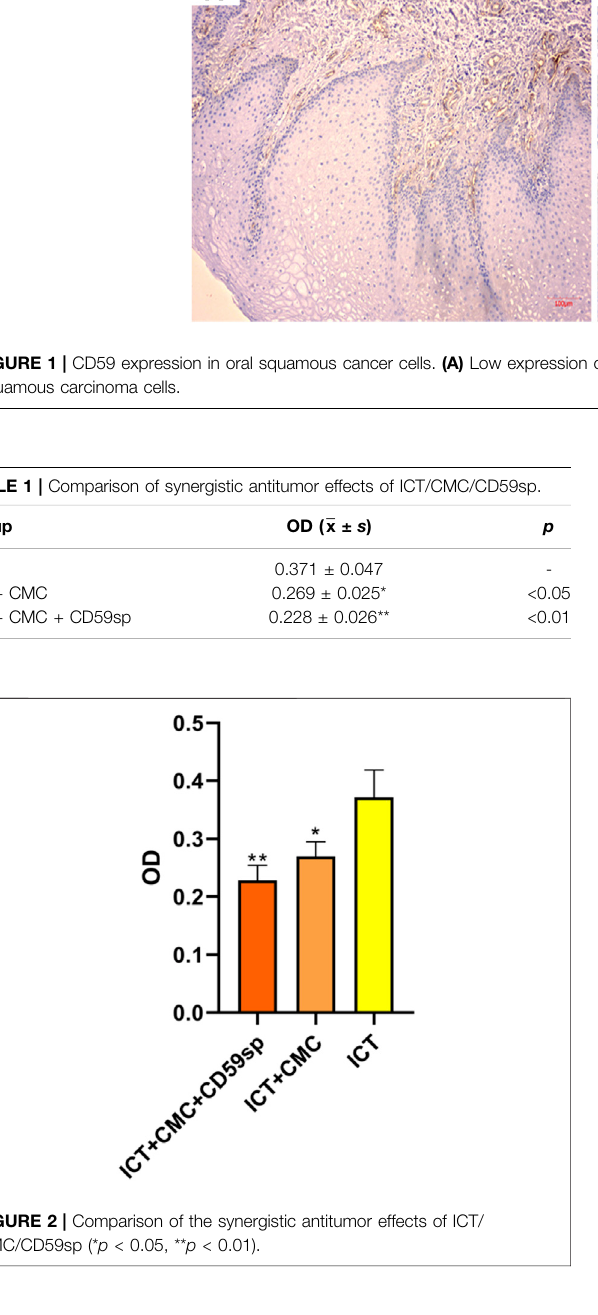
Frontiers in Bioengineering and Biotechnology |